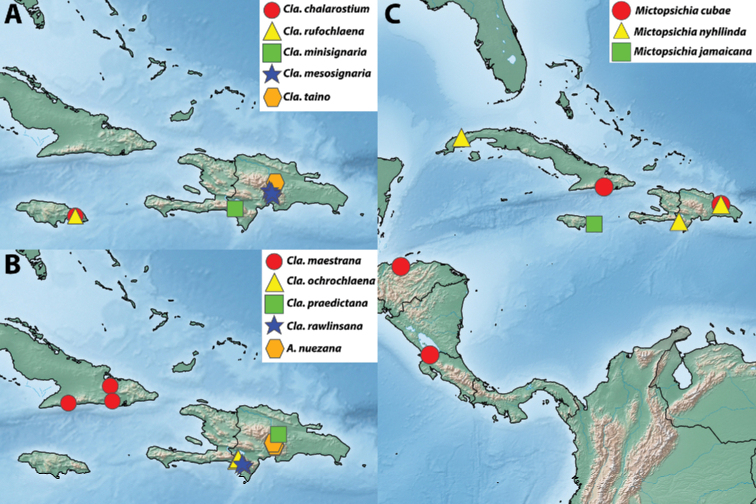
Argyrotaenia, Claduncaria and Mictopsichia species distributions. Legends inset.